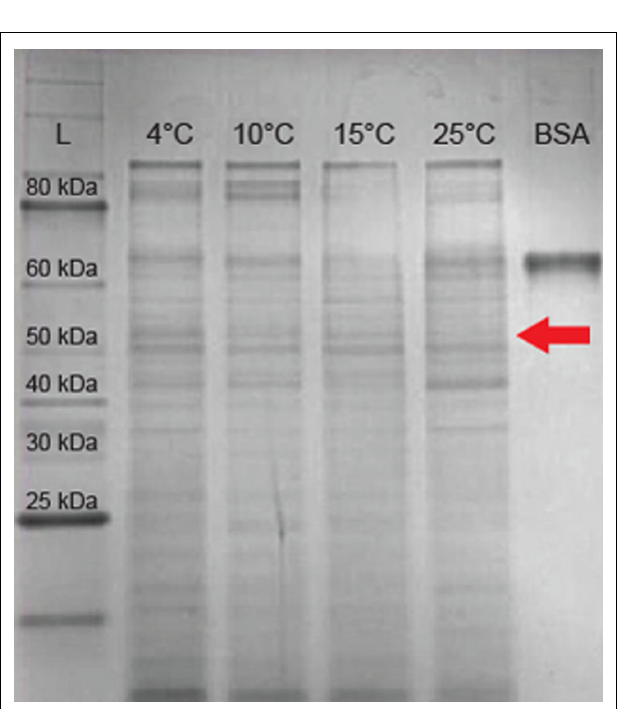
FIGURE 3 | (A) Image transect showing ice structure from the outside edge of the sample to center (left to right in image).The superimposed rectangle delineates a 1.5-mm by 10mm area. (B)